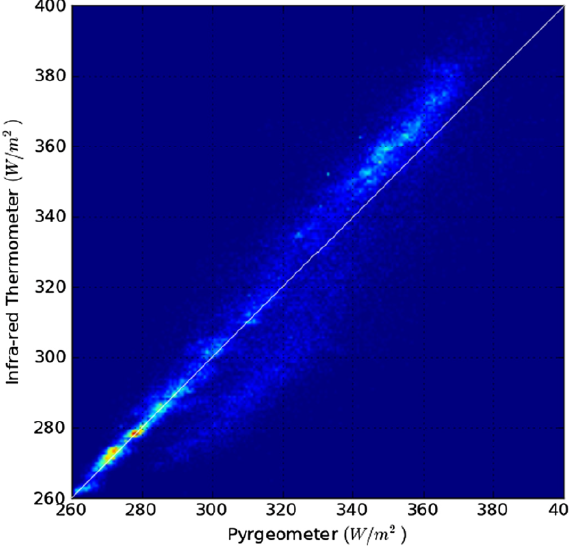
Fig. 7. Atmospheric long-wave downwelling radiation (point-by- point) from an oriented IR thermometer and from a pyrgeometer in winter from 9th to 21st of June 2012. The departure from the equal- ity line indicates sky inhomogeneity. The range of intensities is large with major clusters and large